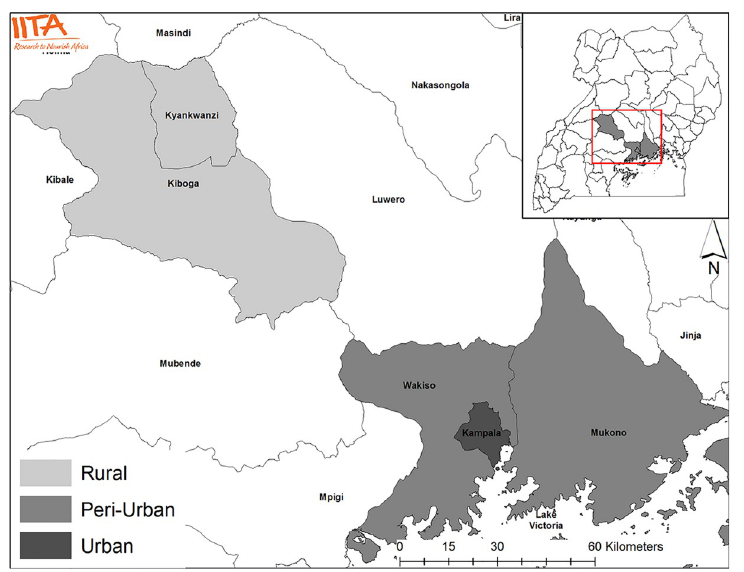
Fig 1. Map of Uganda indicating the locations of the three studied